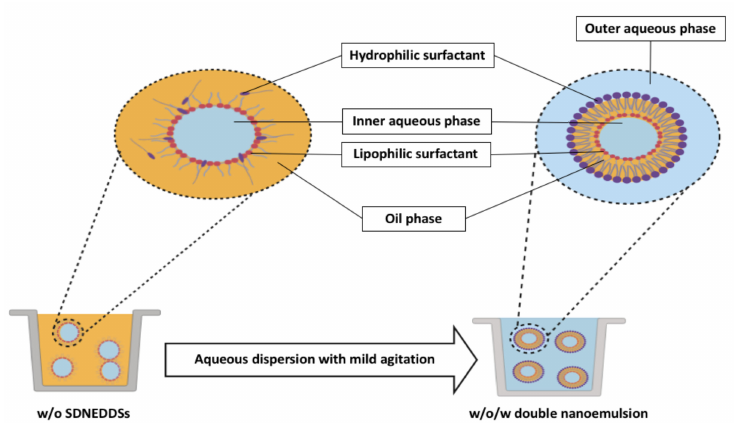
Figure 8. Schematic illustration of the double emulsification technique. Adapted from